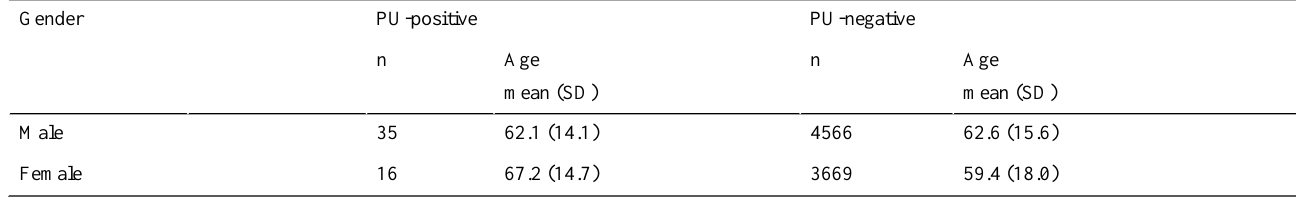
Table 2. Descriptive statistics of patient age.